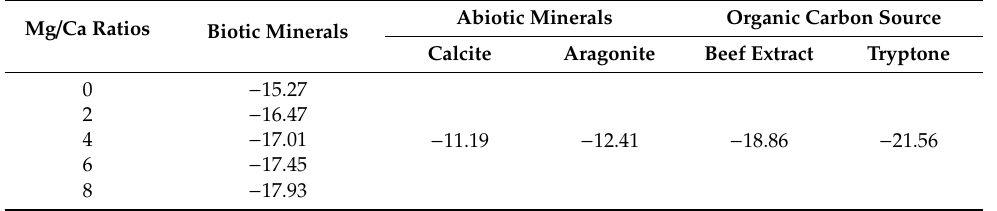
Table 1. Stable carbon isotope values δ 13 C PDB (‰) of the biotic and abiotic minerals and the organic substances. Abiotic Minerals Mg/Ca Biotic Ratios Minerals